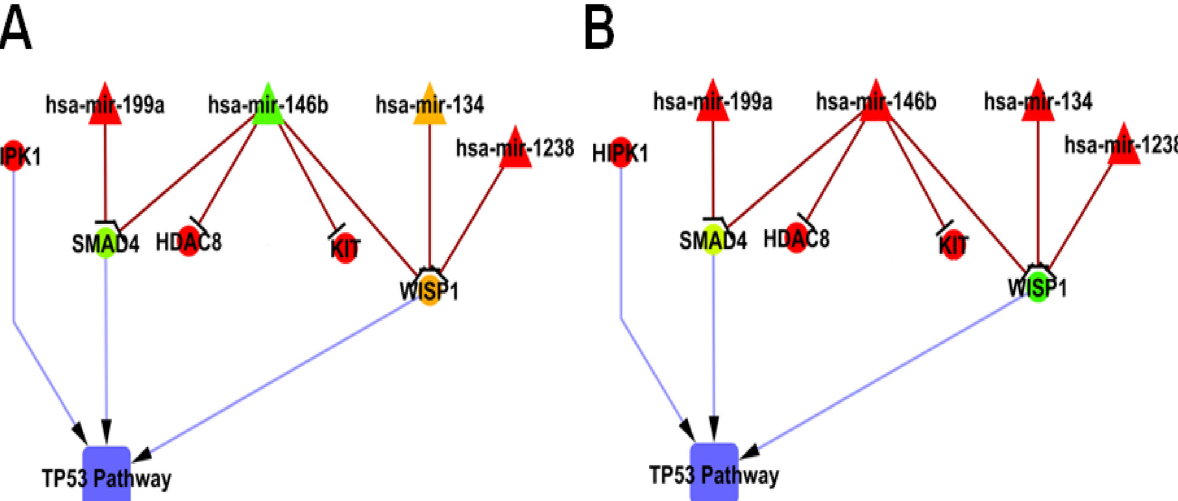
Fig 5. Graphical representation of metastasis-free survival was analysed by Kaplan-Meier analysis. The cumulative proportion surviving at end of the interval (60 months) is represented in percentage. Follow up of 52 patients (2 – 5 years of duration) were considered in the